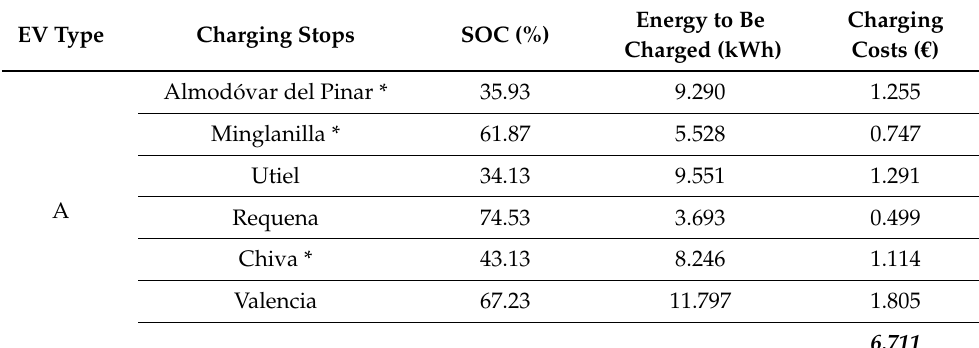
Table 8. Simulation results for EV type A on the Cuenca–Valencia